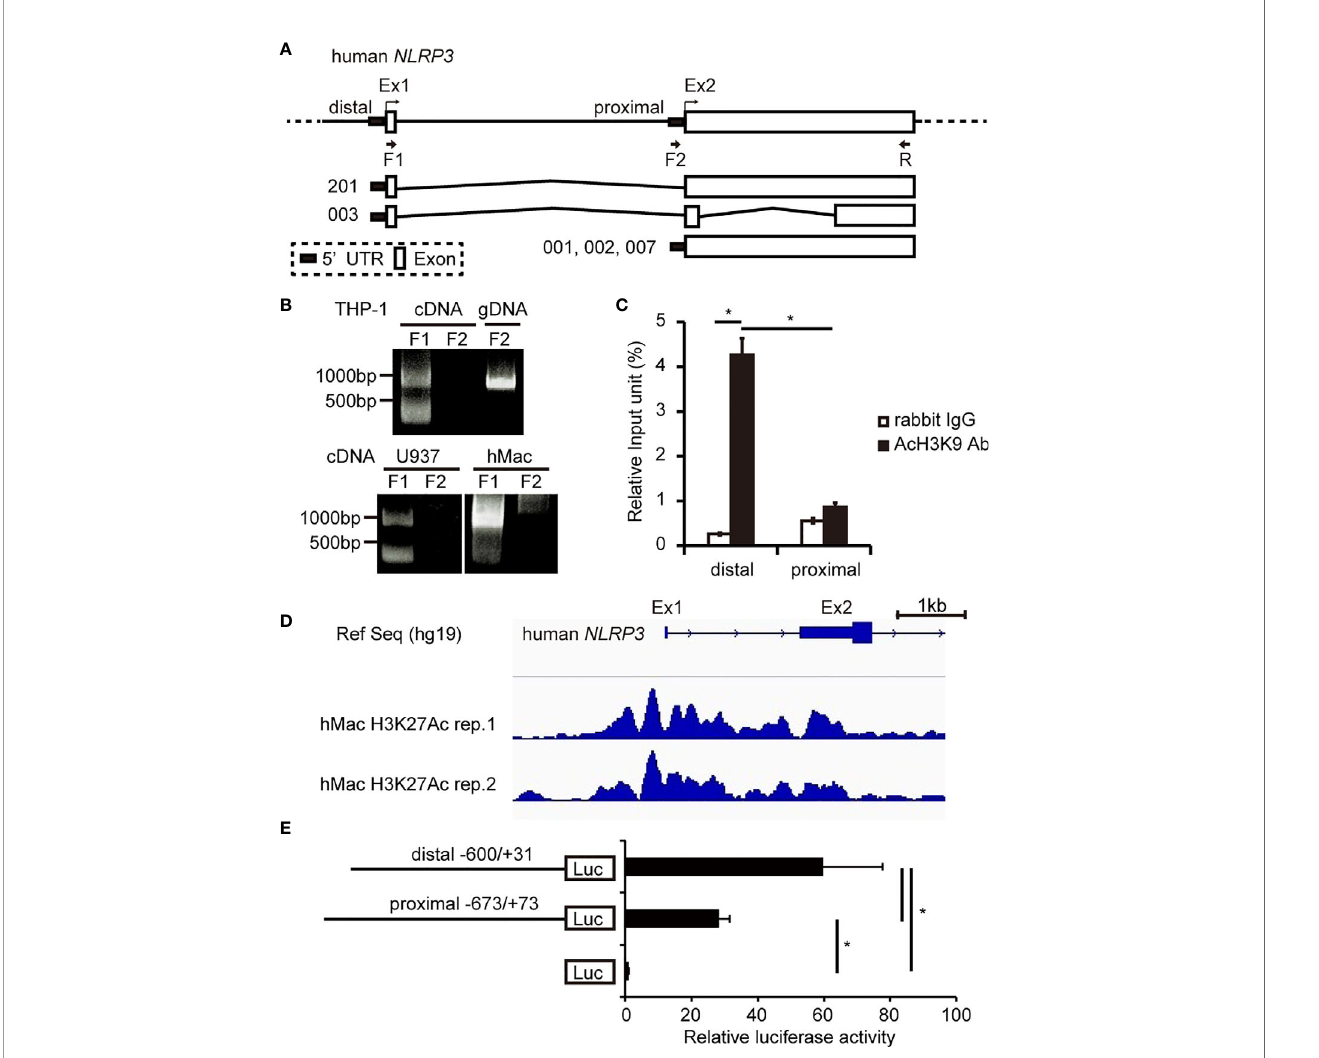
FIGURE 1 | Determination of the predominant promoter for hNLRP3 transcription in human monocytes and macrophages. (A) Human NLRP3 structure. (B) RT- PCR using primers indicated in (A) and cDNA of THP-1, U937, or human macrophages (hMac) as a template. THP-1 genomic DNA was used as a positive control in PCR. (C) ChIP assays with THP-1 cells were performed using anti-AcH3K9 antibody or rabbit IgG. Co-immunoprecipitated DNA was quanti fi ed by qPCR with speci fi c primer sets for the indicated region of hNLRP3 . (D) ChIP-seq of hMac with an anti-acetyl histone H3K27 (H3K27Ac). The region around the distal promoter and the proximal promoter of hNLRP3 is shown. (E) THP-1 cells were transfected with the reporter vectors. Luciferase activities were determined at 48 h after transfection by normalizing fi re fl y activities to Renilla luciferase activity. Data are expressed as the ratio to the empty vector. Data are presented as the mean + S.D. ( n = 3). (C, E) * p < 0.05, Tukey – Kramer